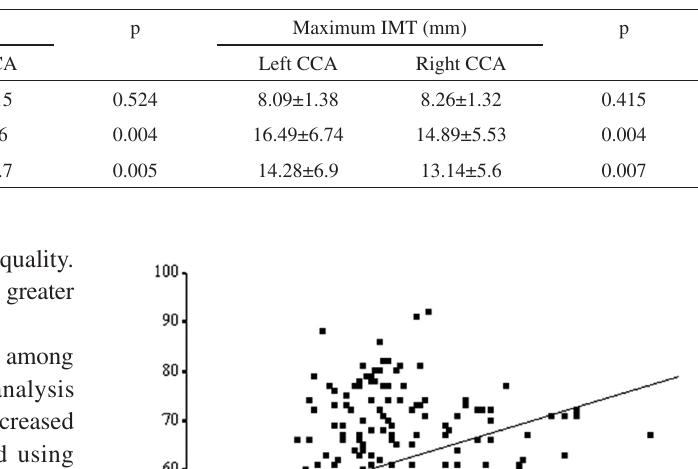
Table II - Comparison of left and right common carotid artery intima-media thickness